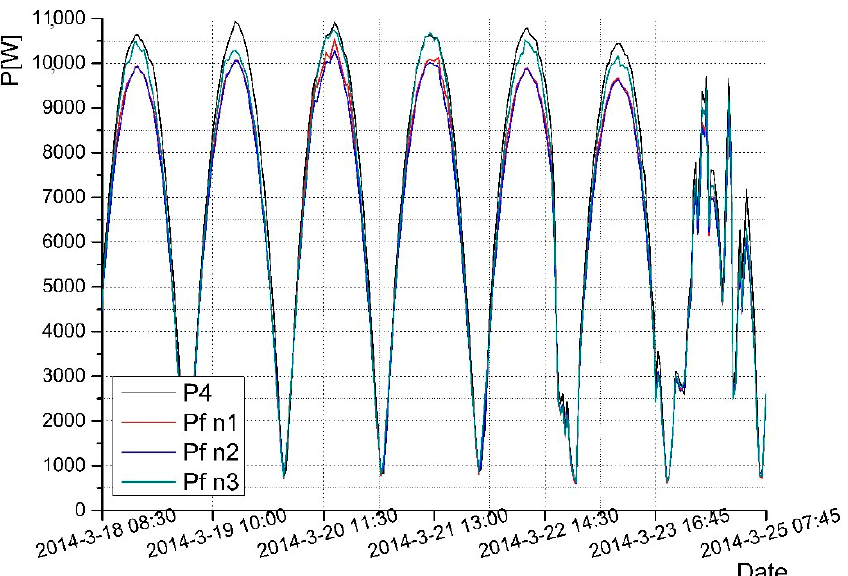
Figure 12. A period at the end of March in which all three networks are seen to underestimate the AC power output.